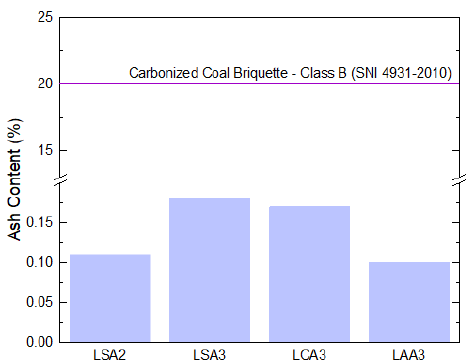
Figure 5. Ash content of the lignin LS2, LS3, LCA3, and LAA3 compared to the carbonized coal briquette SNI 4931–2010.